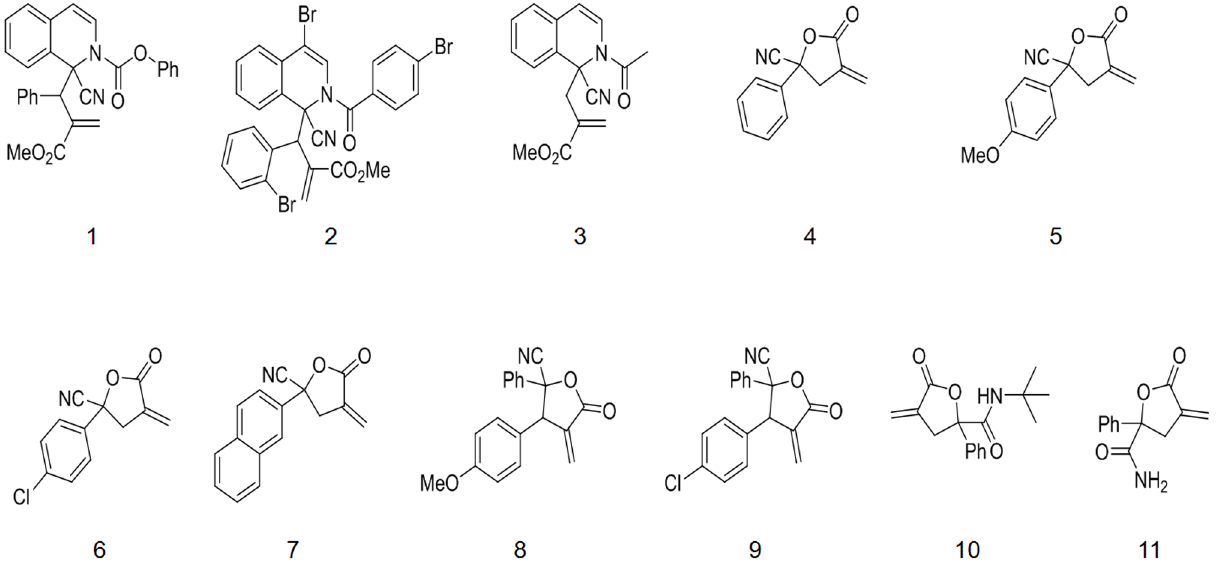
Fig 1. Chemical structure of test